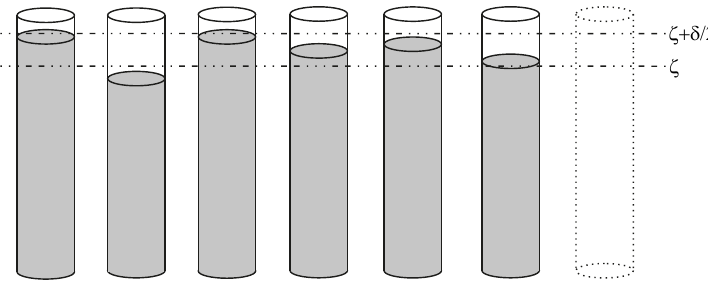
Figure 15. Graphic representation of the implemented balancing methodology.